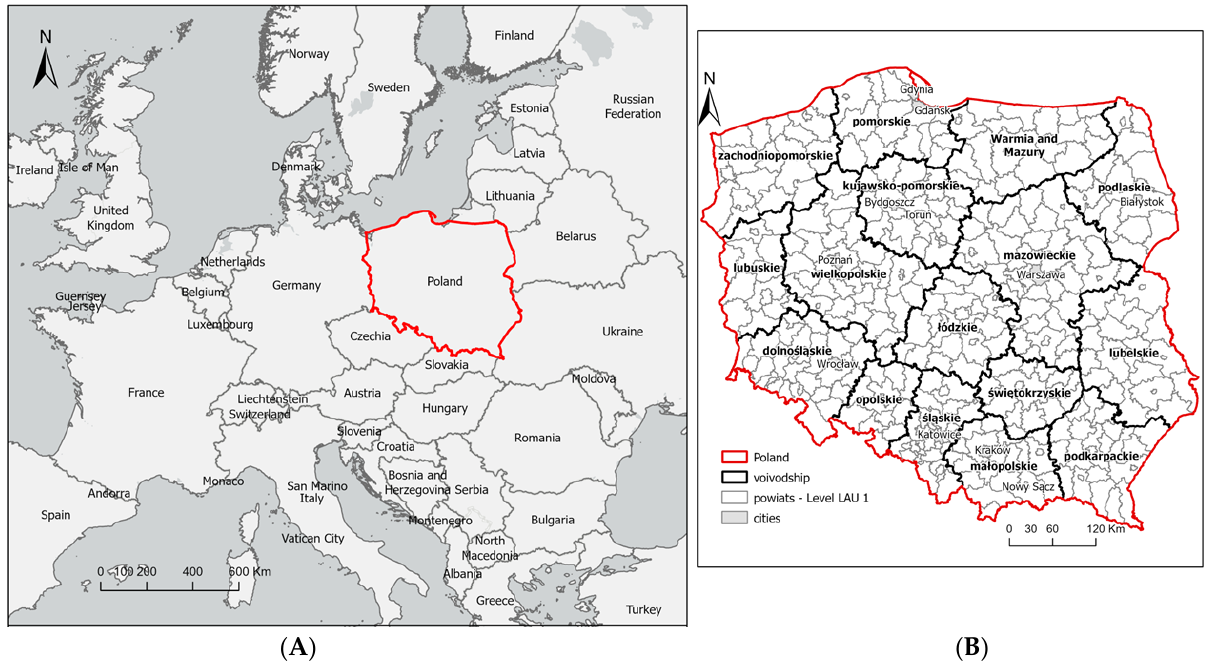
Figure 1. Location study area. ( A ) Location of Poland in Europe. ( B ) Level LAU 1. Source: Own elaboration.